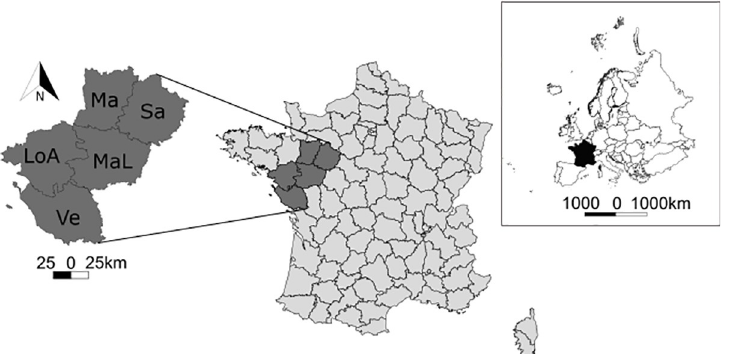
Fig 1. Location of Pays de la Loire Region in France divided into 5 departments. LoA is Loire-Atlantique, MaL: Maine-et-Loire, Ma: Mayenne, Sa: Sarthe, and Ve: Vende´e. Source of the background map: IGN GEOFLA 1 .